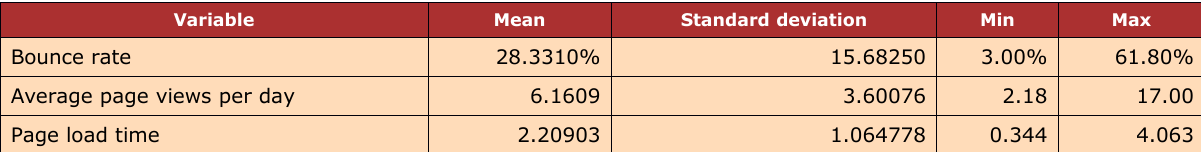
Table 2. Descriptive statistics of visual attention